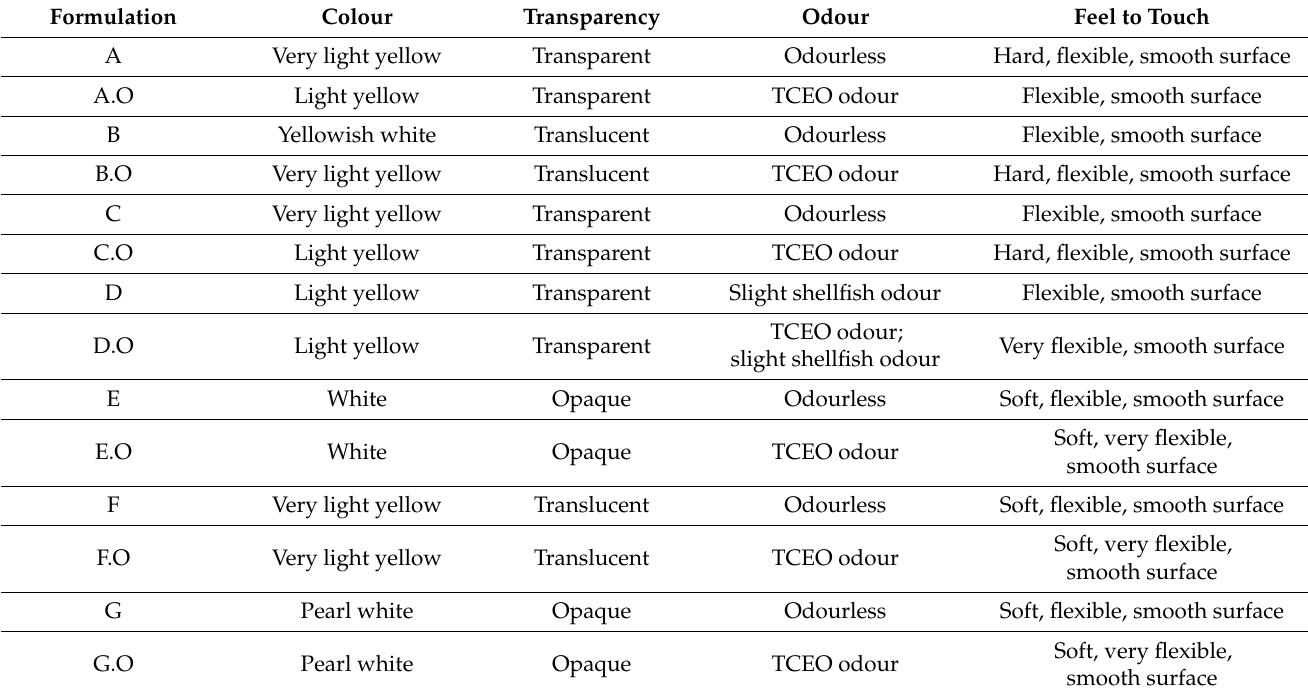
Table 1. Sensorial characteristics of vaginal sheets.